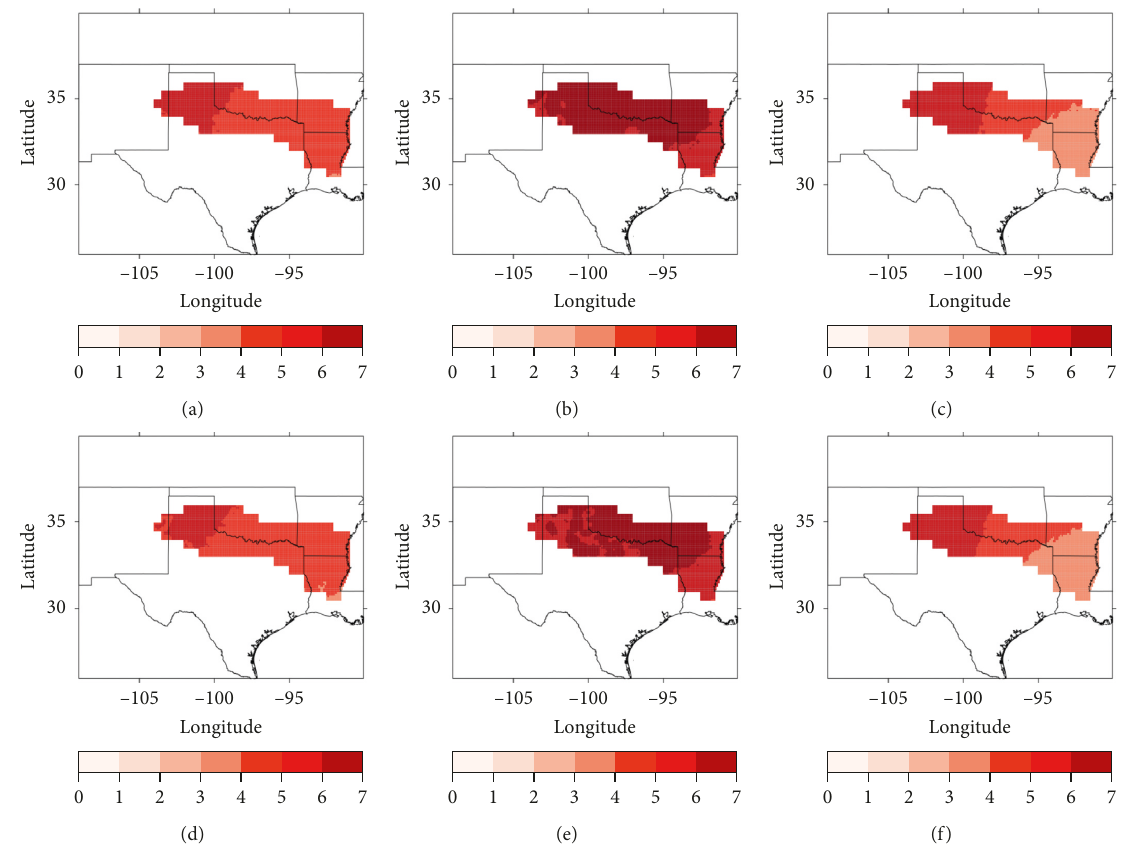
Figure 7: Difference fields for mean daily maximum temperature ( ° C) between historical (1981–2005) and end-of-century (2075–2099) time frames for RCP 8.5. Columns represent the GCMs (CCSM4, MIROC5, and MPI-ESM-LR, from left to right respectively); rows represent downscaling methods, with CDFt on top and EDQM on bottom. Darker shades of red represent higher maximum temperature values. (a) Model: CCSM4, SD: CDFt. (b) Model: MIROC5, SD: CDFt. (c) Model: MPI-ESM-LR, SD: CDFt. (d) Model: CCSM4, SD: EDQM. (e) Model: MIROC5, SD: EDQM. (f) Model: MPI-ESM-LR, SD: